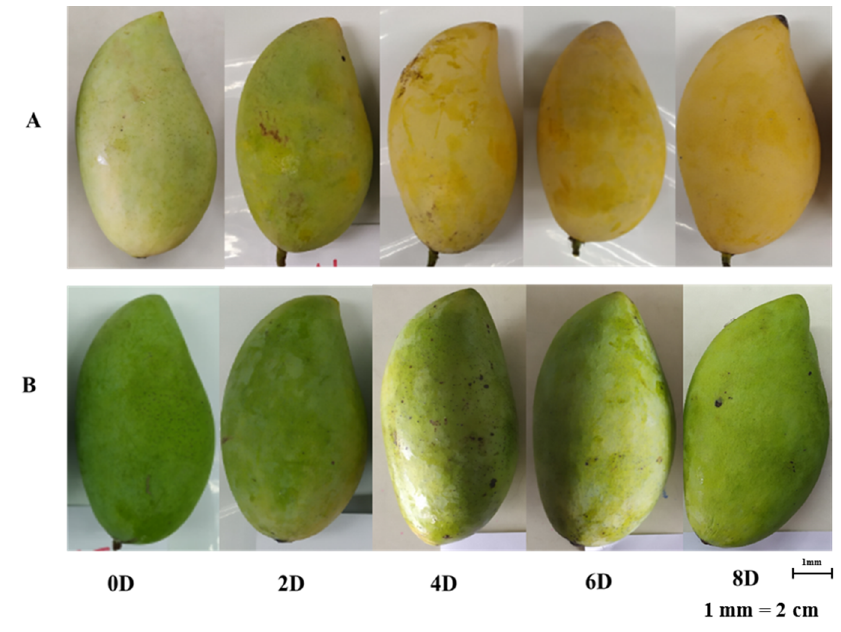
Figure 1. Appearance of Nam Dok Mai mango cultivars at different ripening stages. ( A ) ‘Nam Dok Mai Si Thon’; ( B ) ‘Nam Dok Mai No. 4 ‘(0 D to 8 D = 0 to 8 days of